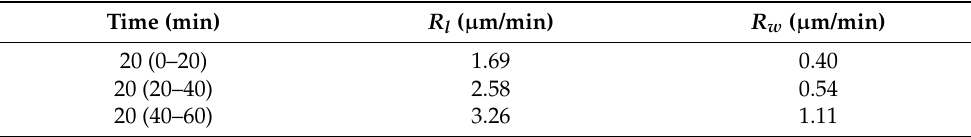
Table 1. Measured growth rates for 2D crystal population sizes.